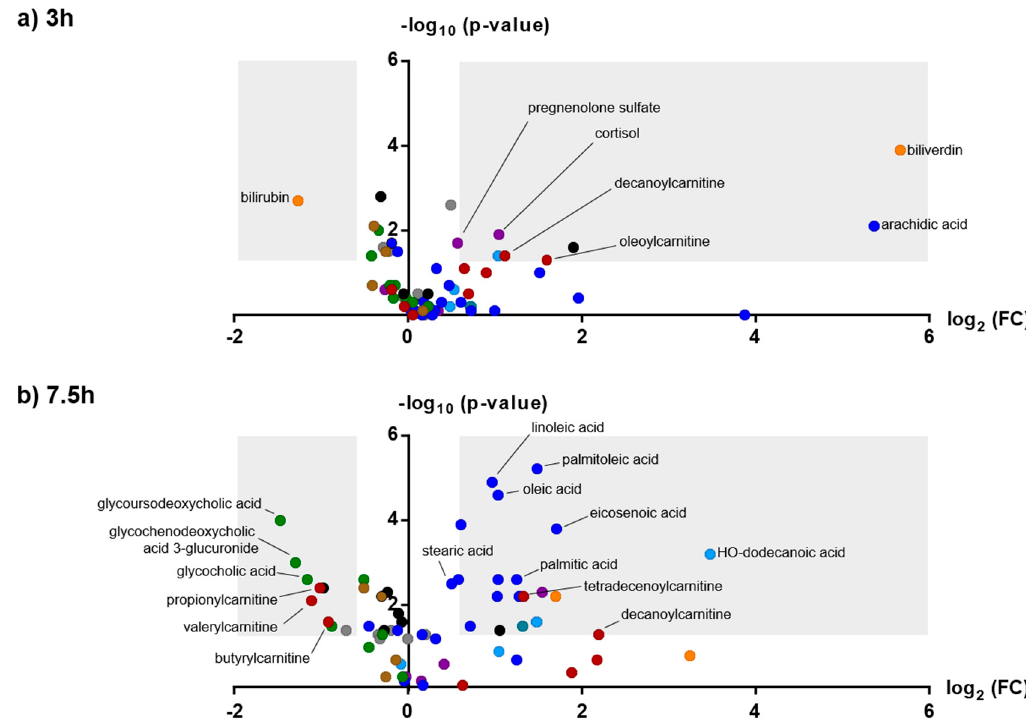
Figure 2. Volcano plots of selected, identified features 3 h ( a ) and 7.5 h ( b ) after oral amphetamine intake. Different compounds classes are depicted in different colors: carnitines (red), long-chain fatty acids (dark blue), medium-chain/short-chain fatty acids (light blue), bile acids (green), amino acids (brown), phospholipids (grey) and biliverdin/bilirubin (orange). All other features remained black. Compounds in light grey areas can be considered as particularly interesting ( − log10 p -value > 1.3; log2 foldchange > 0.6 or < − 0.6).